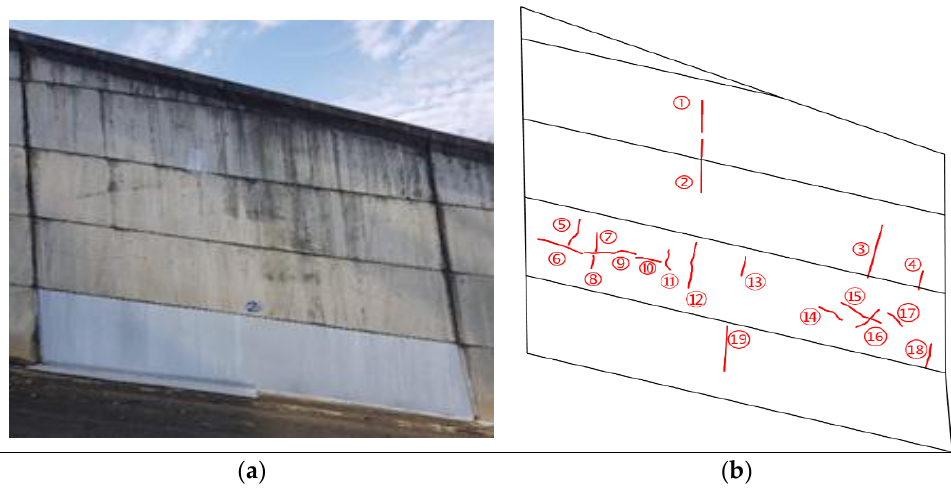
Figure 9. The enlargement of the target structure and crack pattern map by visual inspection. ( a ) Target structure; ( b ) Crack pattern map. Table 2. The width and approximate length of cracks.